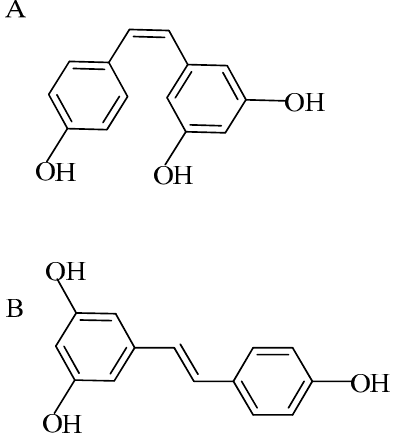
Figure 1. ( A ) Cis-resveratrol; ( B ) trans-resveratrol (molecular weight: 228.24).